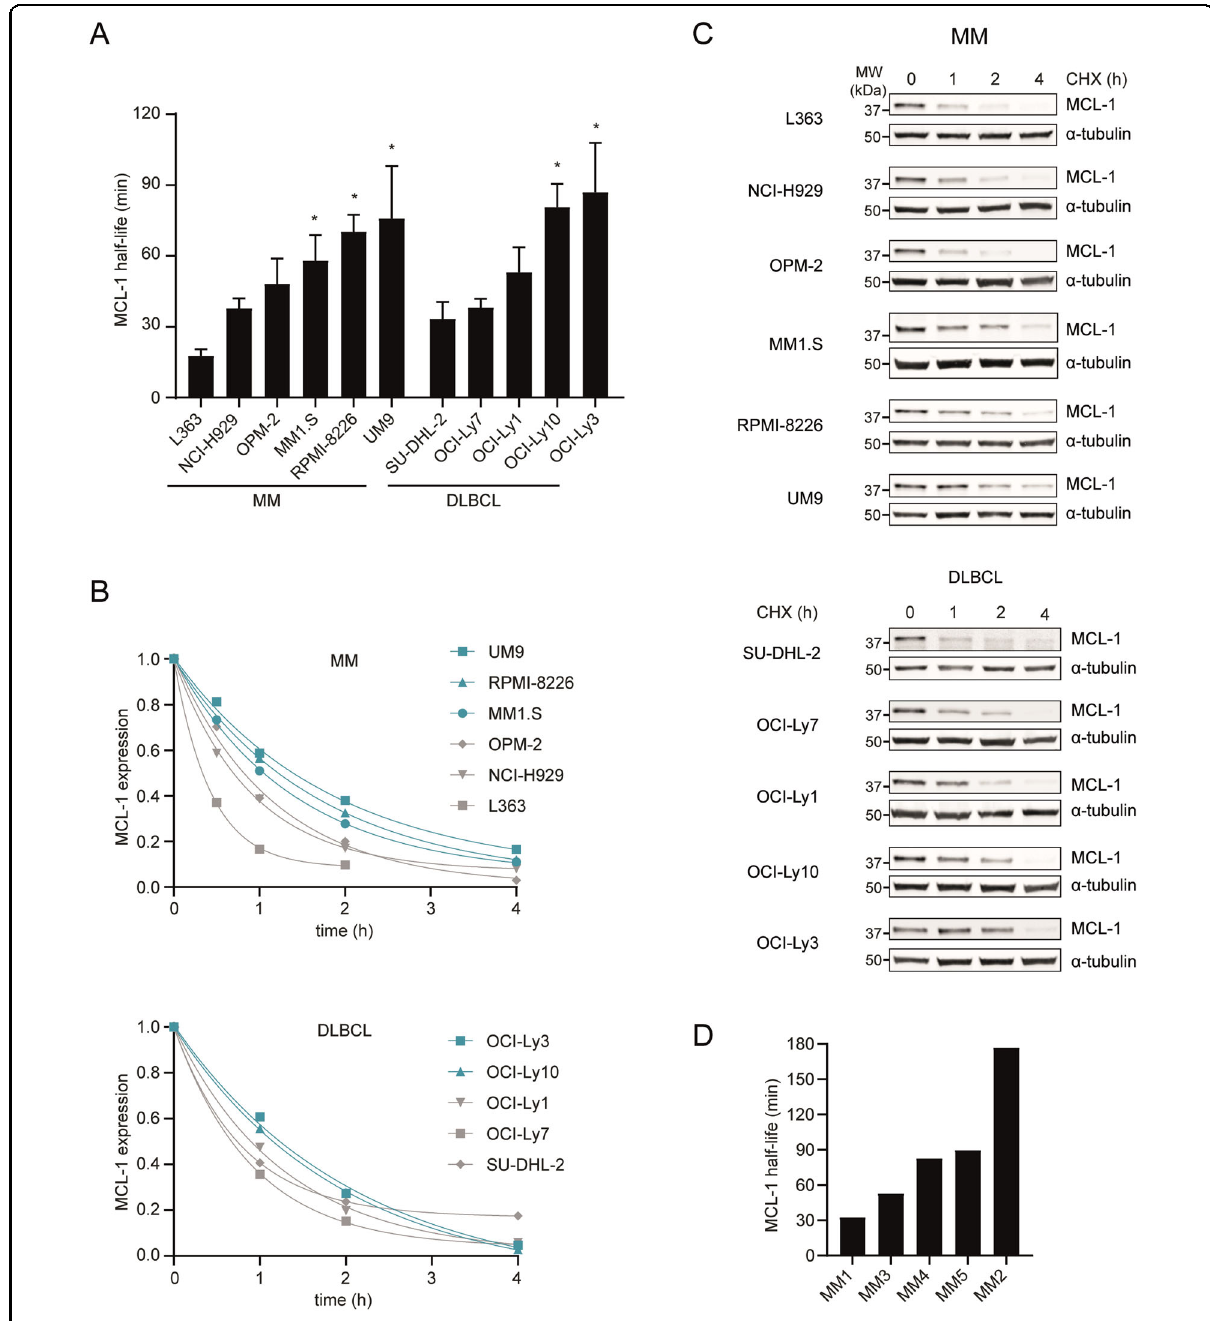
Fig. 1 MCL-1 is stabilized in post-GC B cell malignancies. A – C MCL-1 protein half-life as determined by treatment of MM and DLBCL cell lines with cycloheximide (CHX). Presented data are averages of 3 – 6 independent replicates per cell line ( n = 3 for RPMI-8226, L363, OCI-Ly10, and OCI-Ly7; n = 4 for OPM-2, OCI-Ly3, OCI-Ly1, and SU-DHL-2; n = 5 for MM1.S, UM9; n = 6 for NCI-H929). A Summarized data (mean + SEM) of MCL-1 half-life in 6 MM and 5 DLBCL cell lines. * indicates half-life signi fi cantly longer than 40 min, based on the 95% con fi dence interval. B Representative immunoblot images showing MCL-1 levels after CHX treatment for the indicated time periods. C Non-linear regression analysis (one-phase decay) of MCL-1 degradation over time after CHX treatment. D MCL-1 half-life in primary (CD138-puri fi ed) cells from 5 MM bone marrow aspirates, analyzed by non-linear regression